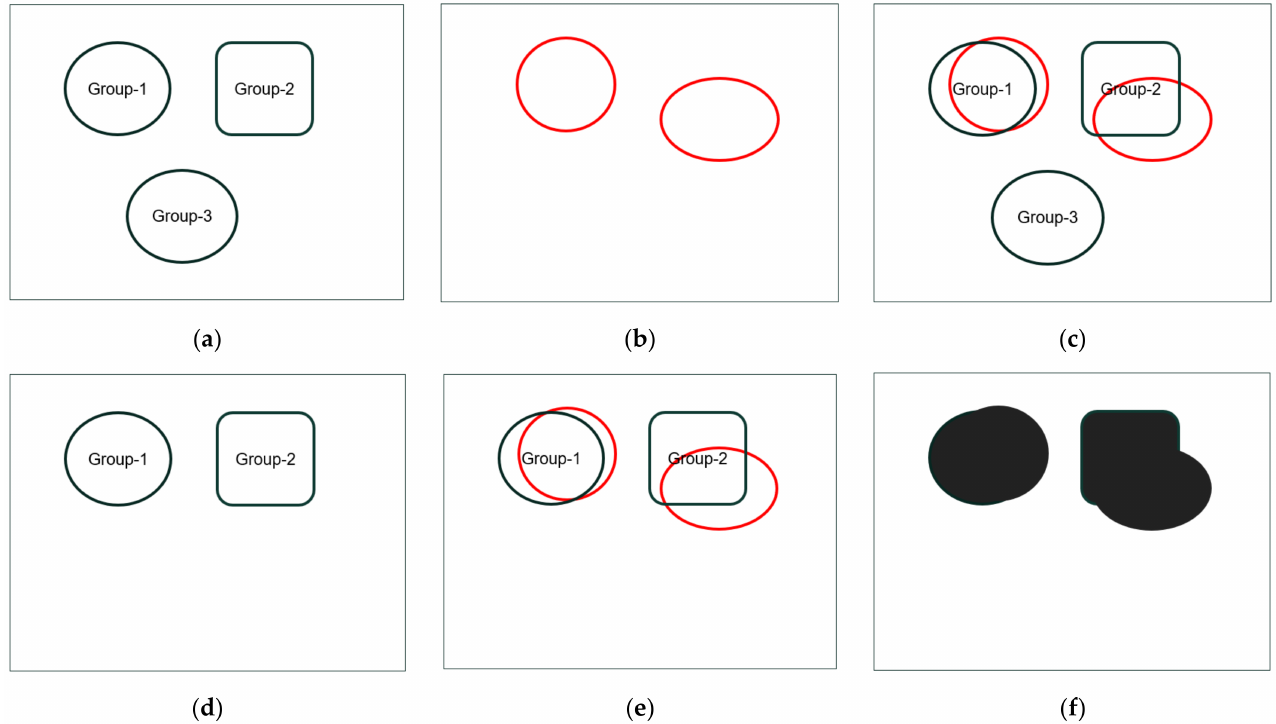
Figure 9. Details of the proposed fusion process. ( a ) Data of model 1 ( b ) Data of model 2 ( c ) Group selection ( d ) Selected groups ( e ) “or” operation and ( f ) Fusion